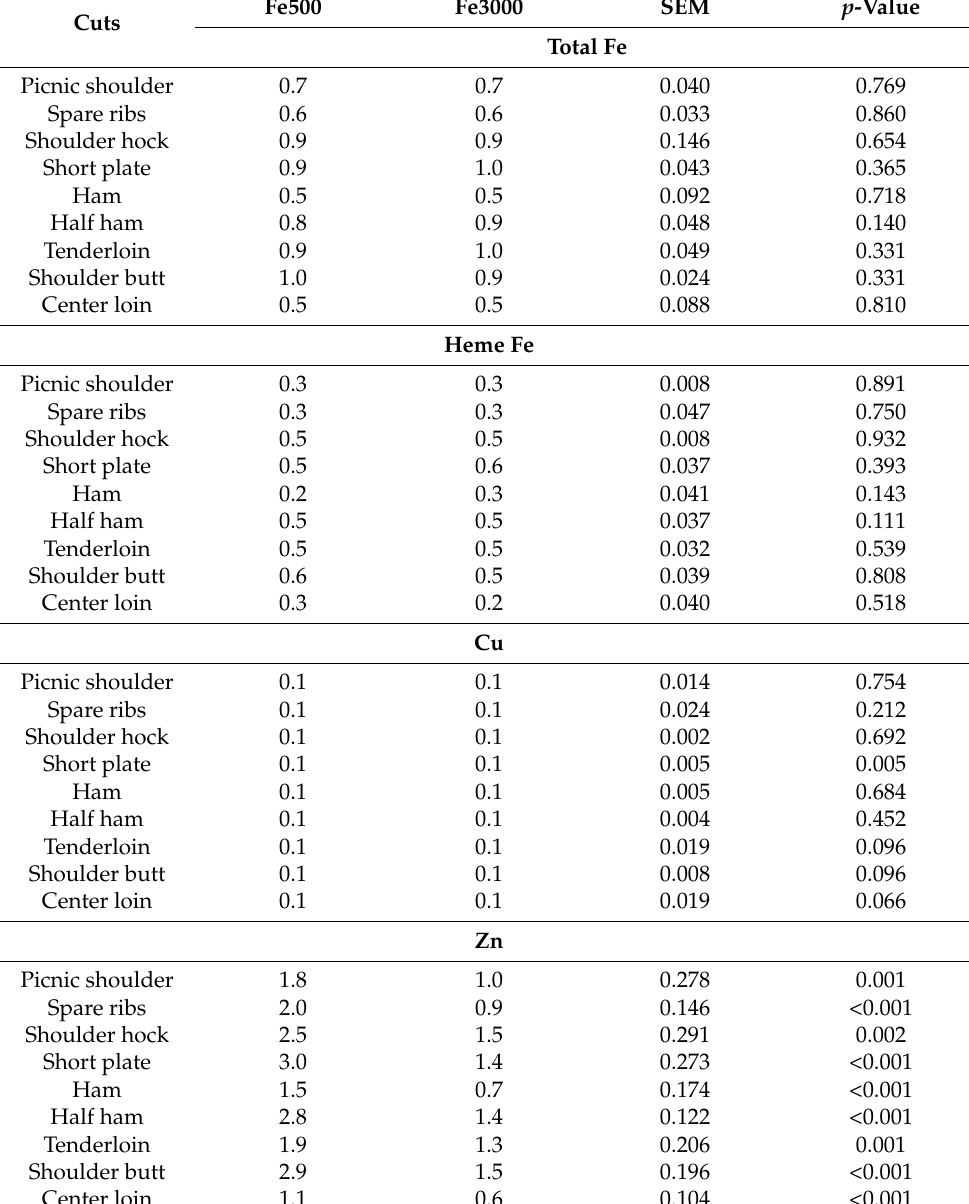
Table 4. Effect of oral iron (Fe) supplementation on total Fe, heme Fe, copper (Cu), and zinc (Zn) contents in cuts of pork (mg/100